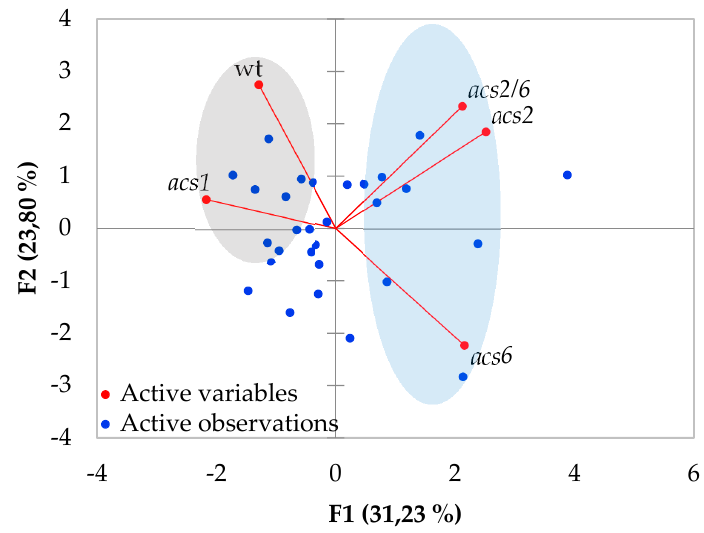
Figure 2. The principal component analysis of the relative AUDPC values of the acs and wt reveals clustered genotypes between the acs2 , acs2/6 , acs6 , and wt, acs1 . The percentage of variation explained by the plotted principal coordinates is indicated on the axes.